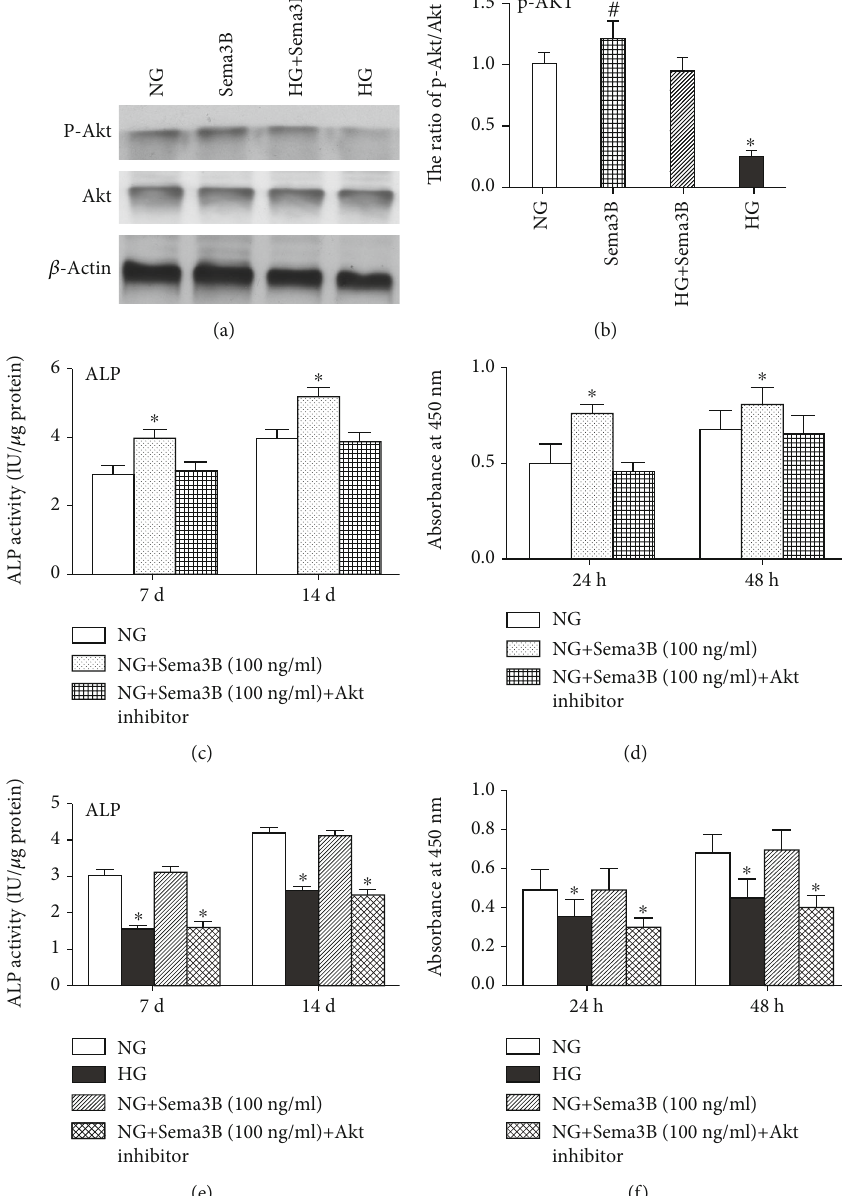
Figure 6: E ff ects of Sema3B on BMSCs by the Akt pathway under HG treatment. (a) Representative western blots are shown. (b) The expression levels of phospho-Akt and Akt were evaluated by western blotting. (c) ALP activity of BMSCs was detected using an ALP activity detection kit. (d) BMSC proliferation was assessed by CCK-8 assay. Cells were pretreated with an Akt inhibitor (MK2206) (10 μ M) for 2h followed by stimulation with HG or HG+ Sema3B. Then, (e) ALP activity of BMSCs and (f) the proliferation of BMSCs were assessed. Data are expressed as the mean ± SEM ( n = 3 ). ∗ P < 0 : 05 compared to the other samples, # P < 0 : 05 compared to the control